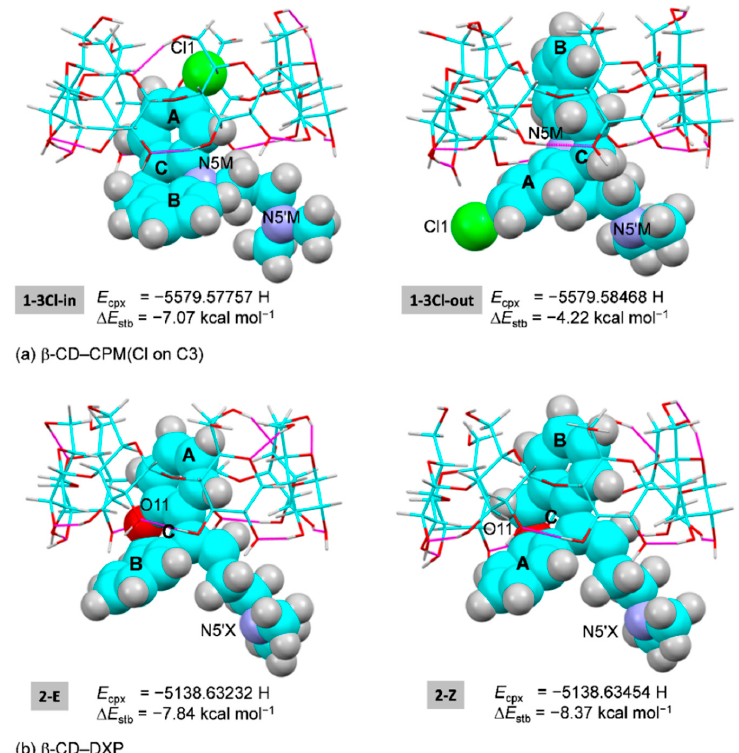
Figure 6. Inclusion complexes of ( a ) β -CD − CPM (Cl on C3) with Cl inside and outside the β -CD cavity, and ( b ) β -CD − E / Z -DXP, derived from DFT full-geometry optimization in the gas phase. For better comparison, the energy of complex ( E cpx ) and the stabilization energy ( Δ E stb ) are given; see also Figures 7 and S1, Tables 3 and S7 for β -CD − CPM (Cl on C7). The H-bonding interactions are indicated by the magenta